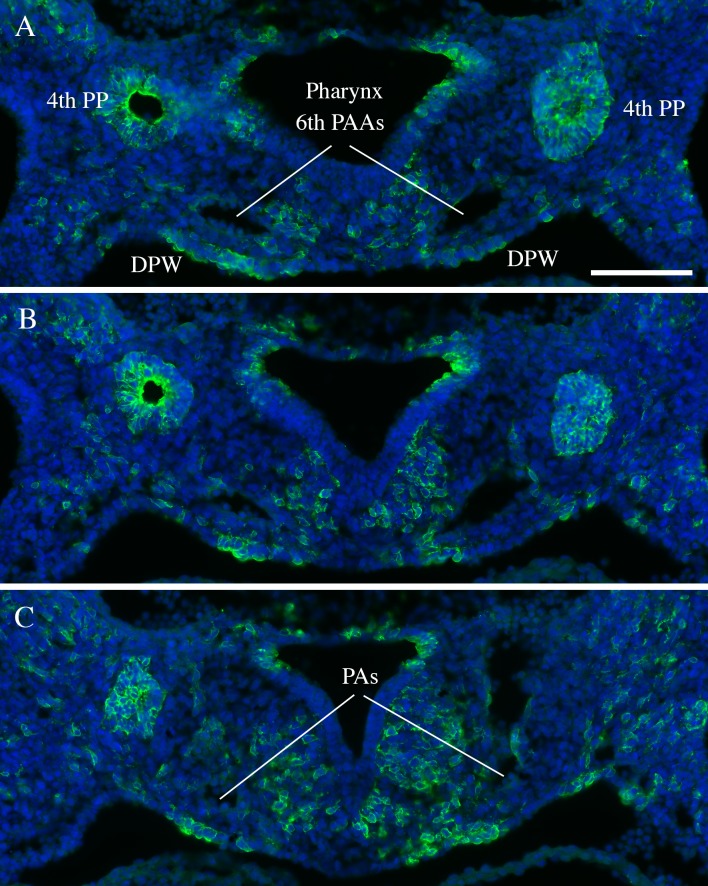
Tbx1 expression in mouse embryos.Transverse section of a E10.5 Tbx1cre/+; RosamT/mG embryos immunostained with an anti GFP antibody (green). GFP positivity indicate cells that have expressed Cre recombinase. A, B, and C refer to 3 adjacent sections (cranial -> caudal) that span the junction between the 6th pharyngeal arch arteries (PAAs) and the putative pulmonary arteries (PAs). PP: pharyngeal pouches; DPW: dorsal pericardial wall. Scale bar is 100 micrometers.